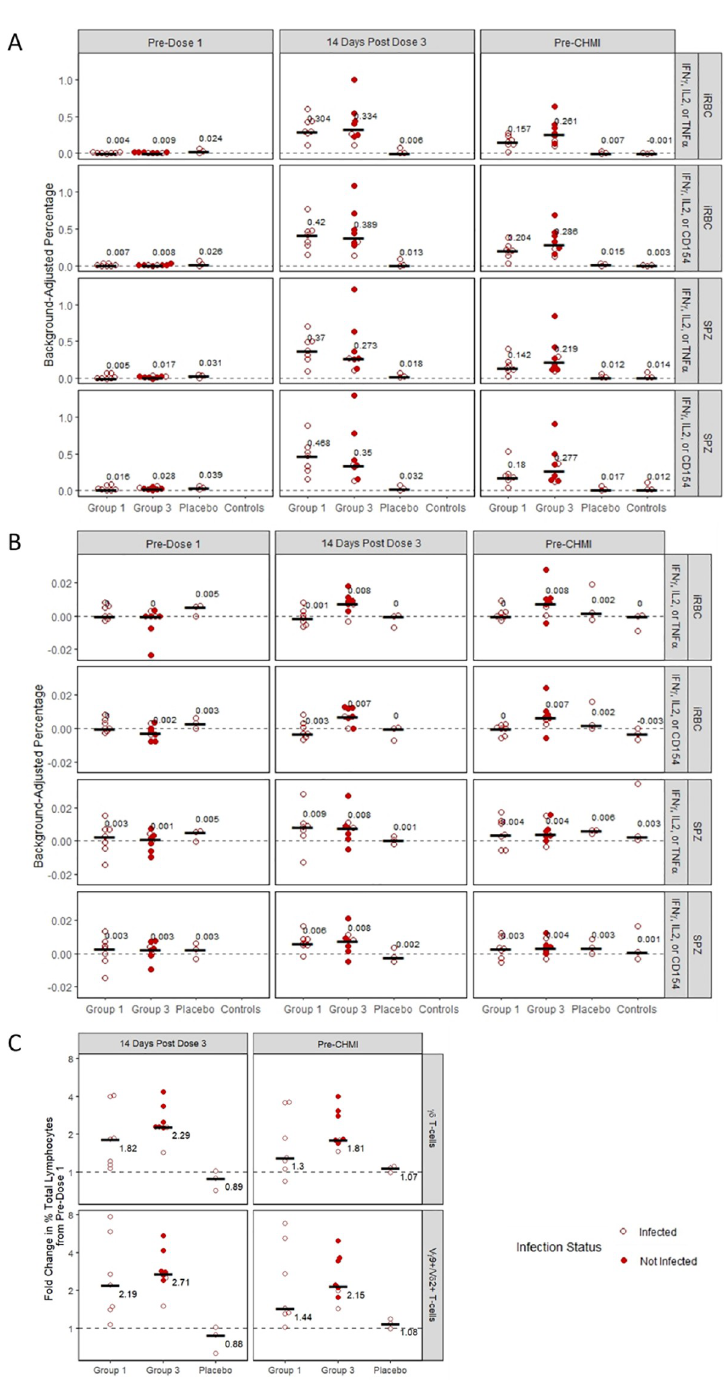
Fig 6. Cellular immune parameters in vaccinated and control participants. ( A ) Background-adjusted percent of CD4 T-cells expressing specific cytokines upon stimulation with malaria antigens by time point among vaccinated subjects in Groups 1 and 3, placebo recipients, and infectivity controls. ( B ) Background-adjusted percent of CD8 T- cells expressing specific cytokines upon stimulation with malaria antigens by time point and treatment group. ( C ) Fold Change in γδ T-cells and in the V γ 9+/V δ 2+ subset from pre-vaccination to 14 days post-vaccination and to pre-CHMI by treatment group. Bars and text show medians in all panels.